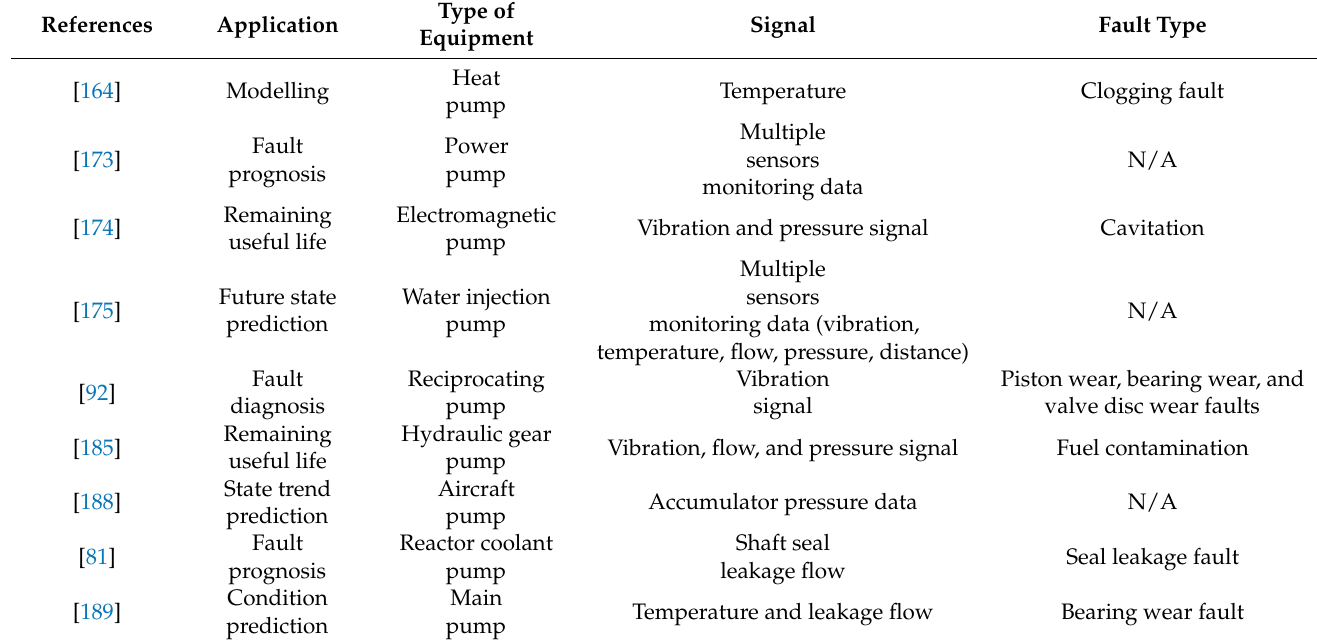
Table 22. Pump condition monitoring using recurrent neural network.